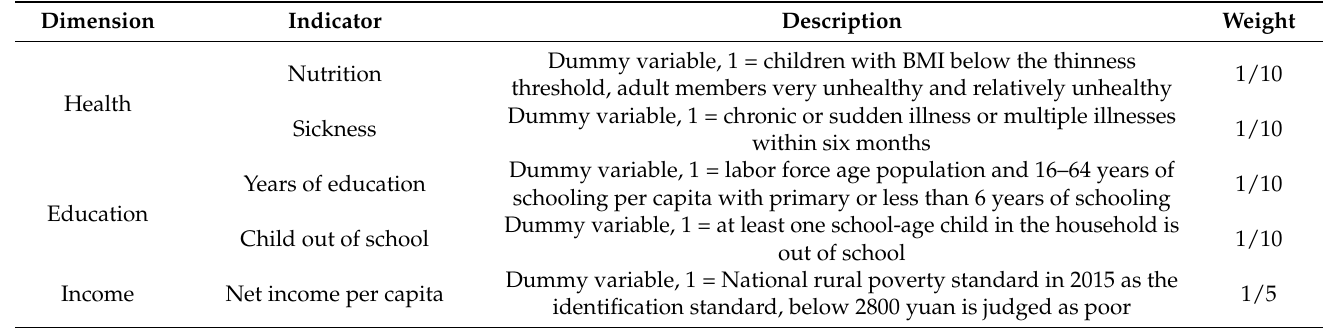
Table 1. Multidimensional poverty indicators and critical deprivation